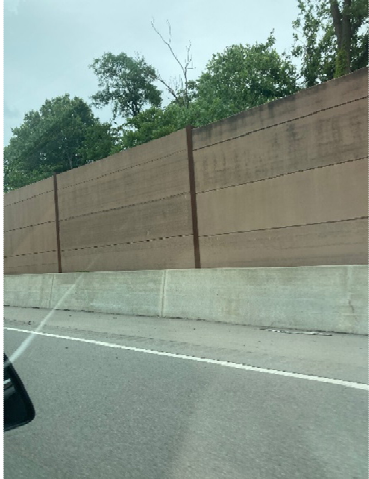
Figure 8. An indoor classroom without windows.